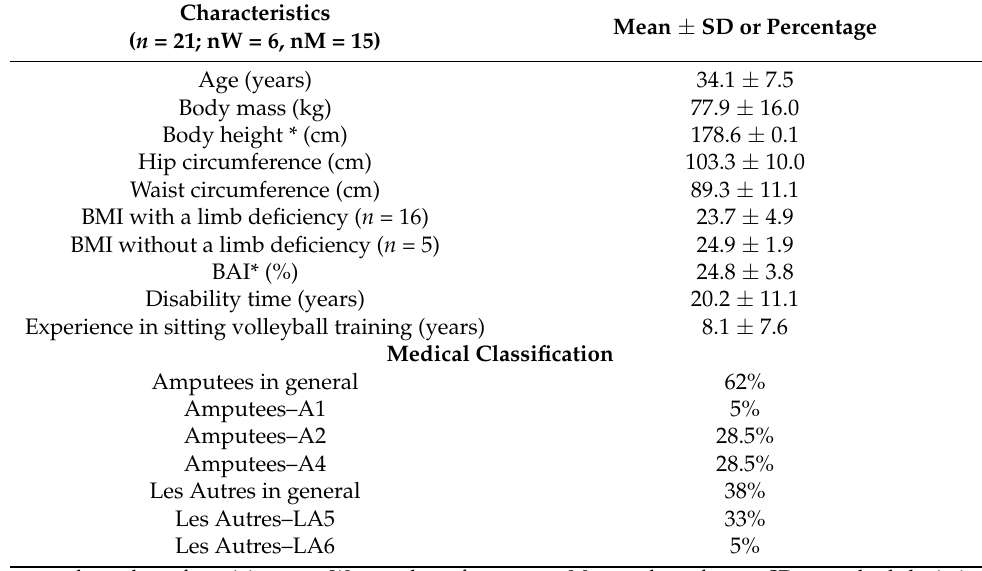
Table 1. Characterization of the sitting volleyball